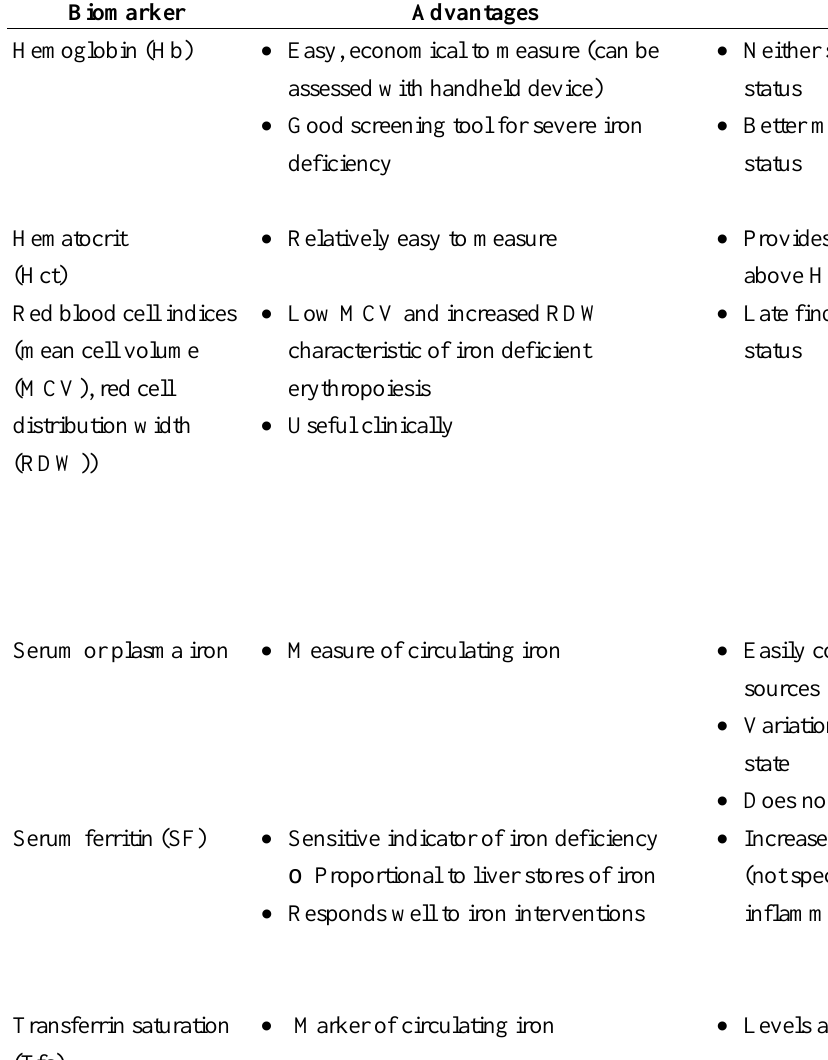
Table 1. Summary of iron indicators. Iron indicators are ranked from easiest and most economical to measure, to most expensive and most invasive.